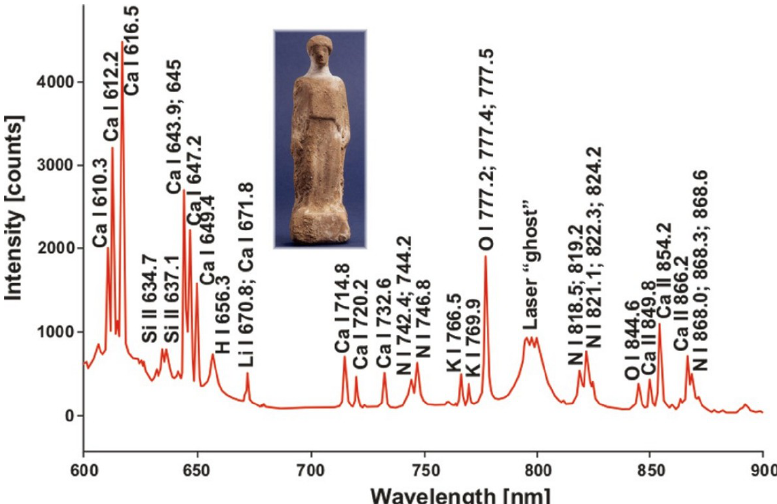
Figure 9. LIBS spectrum of ancient terracotta figure (shown at small